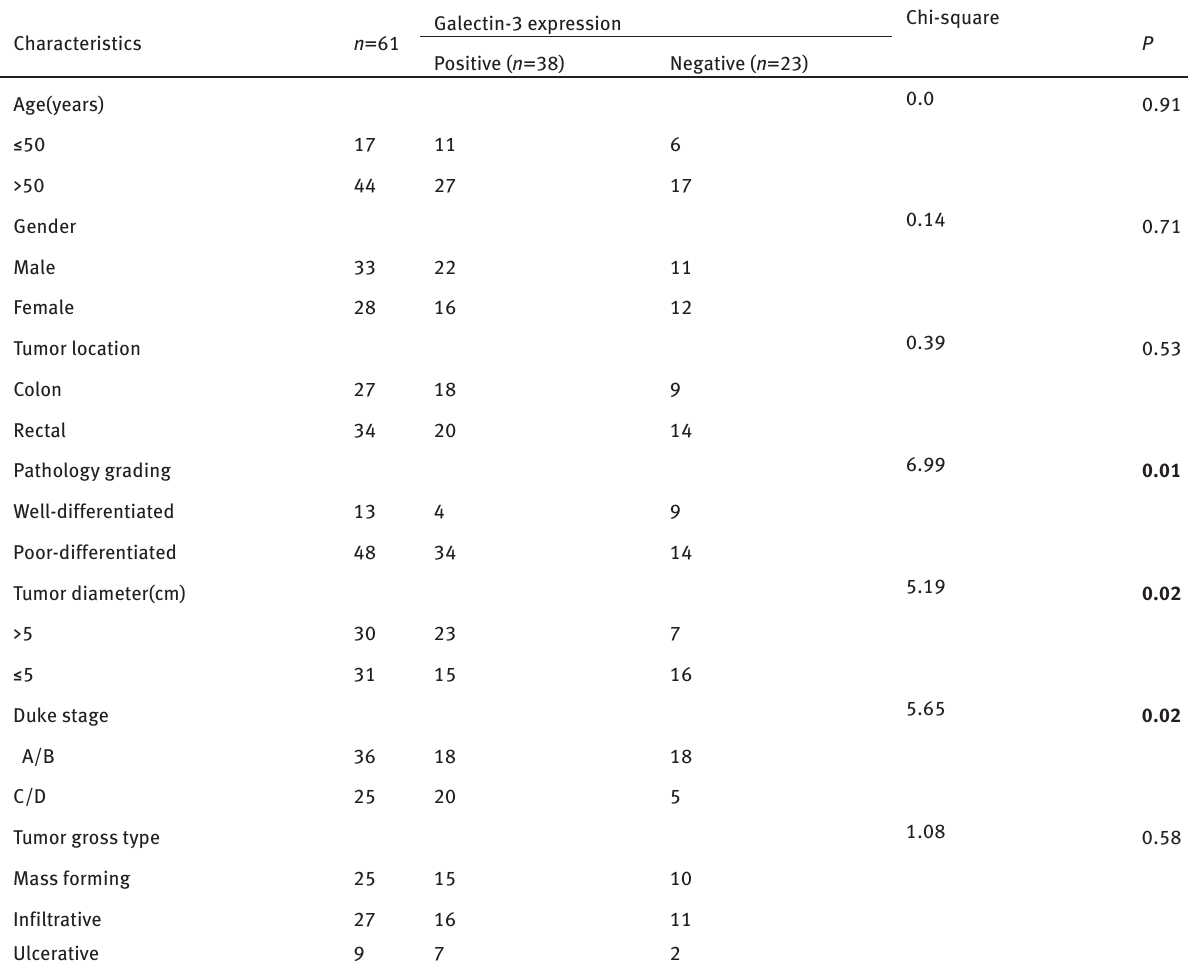
Characteristics